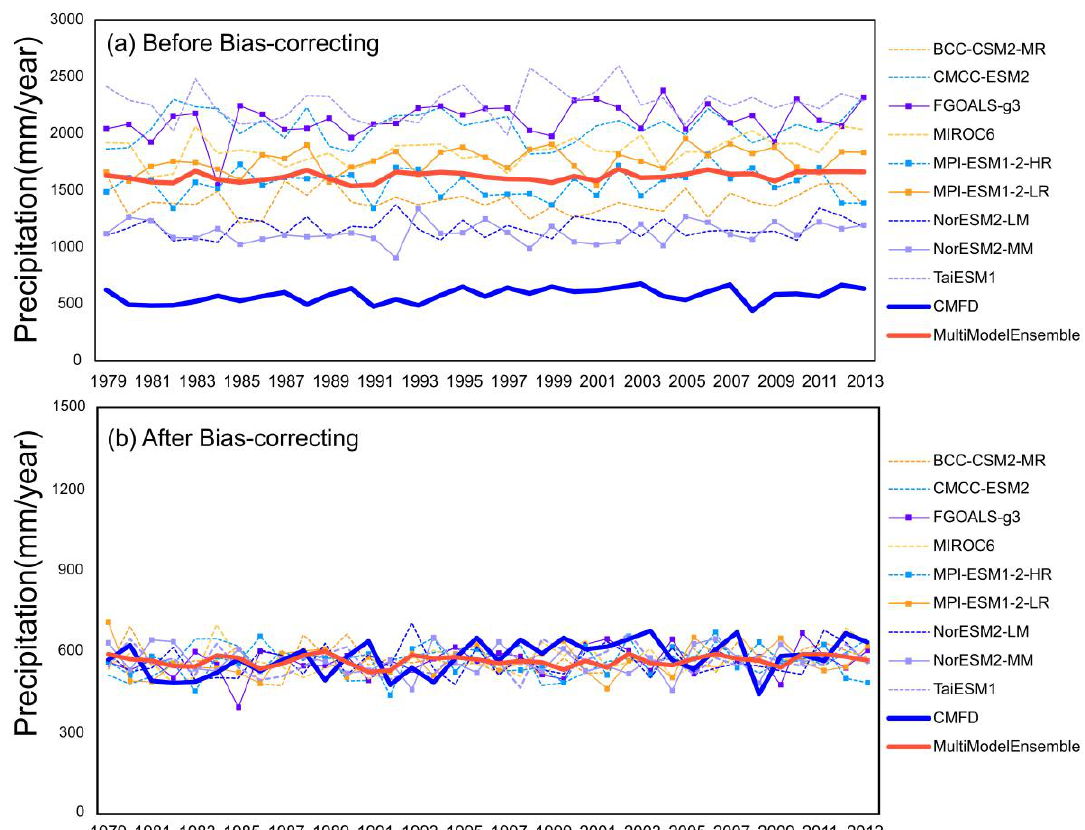
Figure 2. Annual mean precipitation in observation and CMIP6 models before ( a ) and after ( b ) BCSD over YZRB.